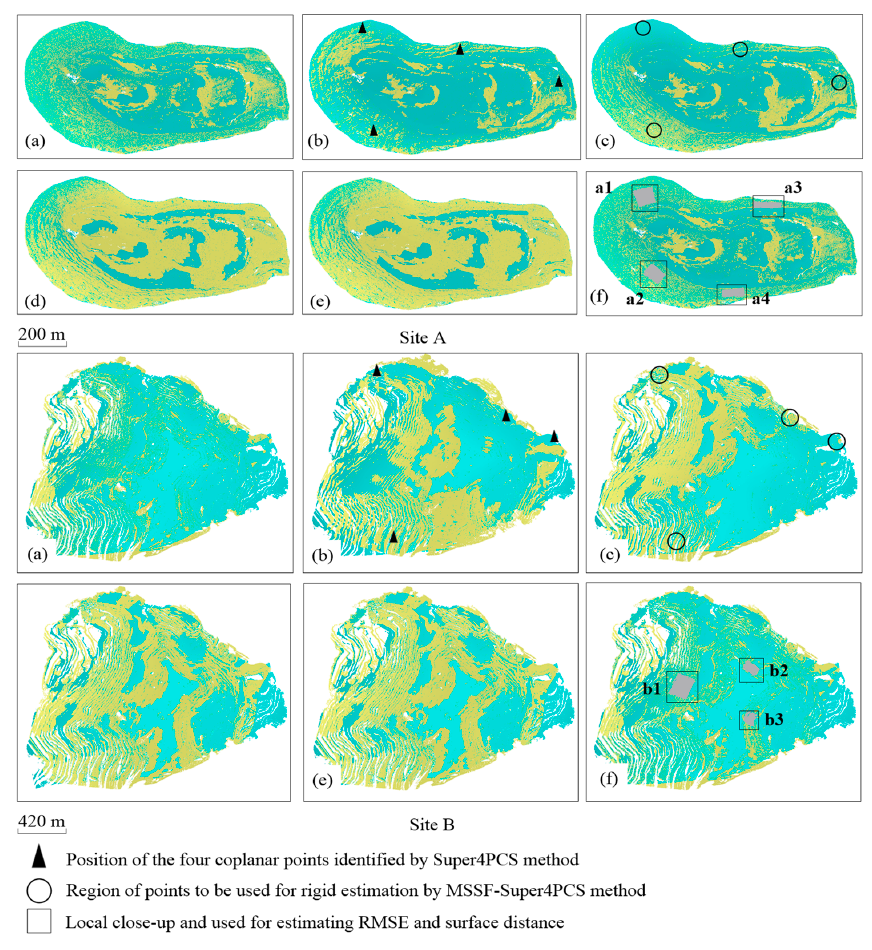
Figure 6. Registration results of both sites yielded by ( a ) manual-based, ( b ) Super4PCS, ( c ) MSSF-Super4PCS, ( d ) Super4PCS+ICP, ( e ) MSSF-Super4PCS+ICP, and ( f ) the proposed method.